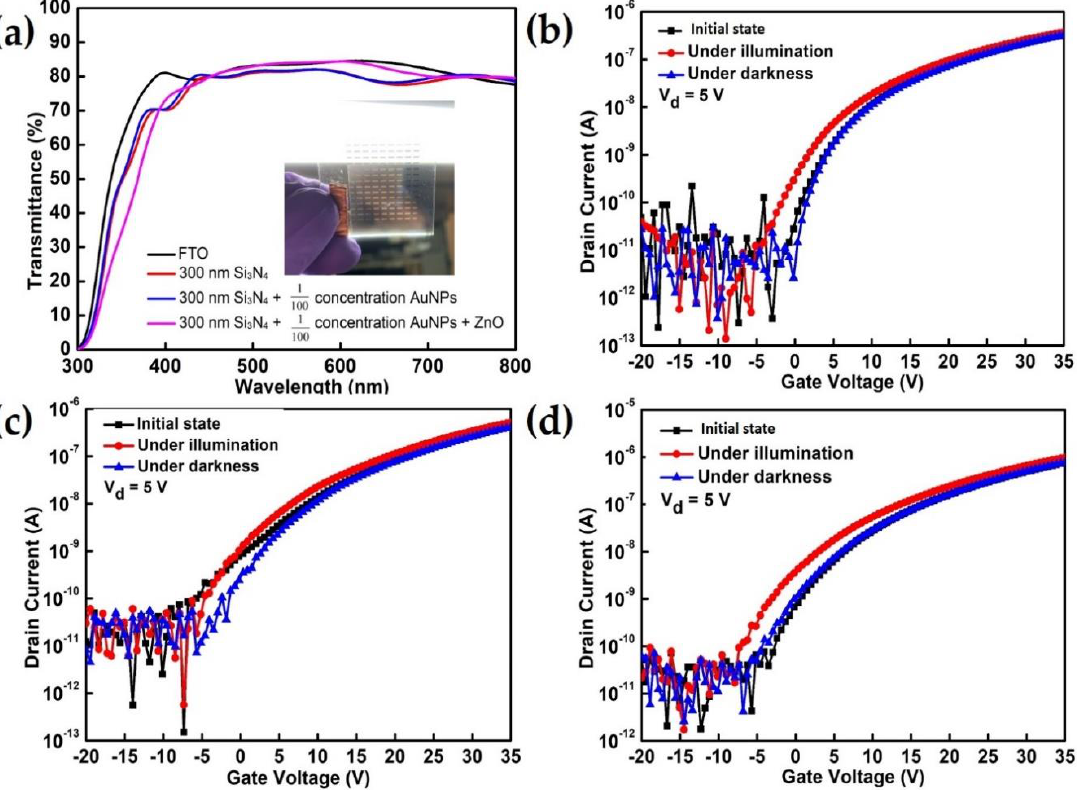
Figure 4. ( a ) Transmittance of the phototransistor based on ZnO and AuNPs on the transparent glass of an FTO substrate (inset image shows the optical photo on our devices). Typical transfer characteristics of the ZnO / AuNPs-based structure TFTs with and without visible-light illumination, where AuNPs were placed between the semiconducting channel ZnO and Si 3 N 4 gate dielectric with concentrations of ( b ) 1.26, ( c ) 12.6, and ( d ) 126 pM.